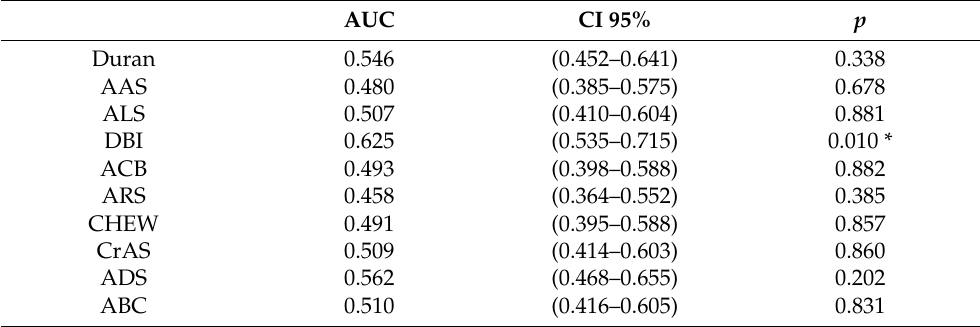
Table A12. Area under the curve (AUC) of cognitive impairment assessment in 12–15 months